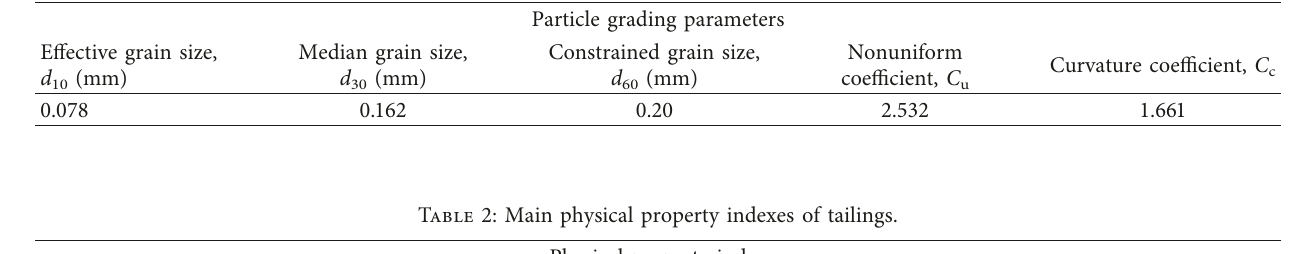
Table 1: Particle composition parameters of tailings.